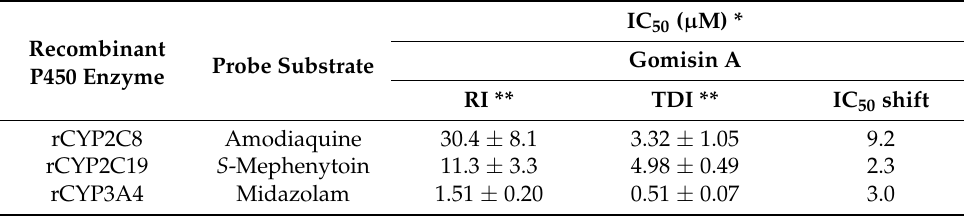
Table 4. Inhibitory effects of gomisin A against CYP2C8, CYP2C9, and CYP3A4 isoforms in human recombinant P450 isoforms.